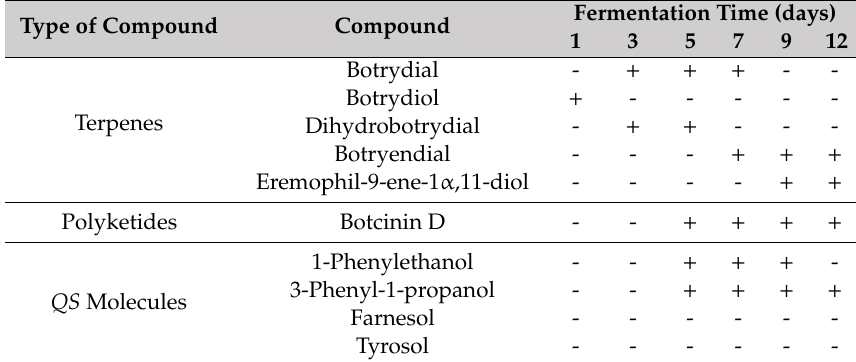
Table 2. Compounds detected in B. cinerea extracts according to the time of fermentation. Fermentation Time (days) Type of Compound Compound 1 Botrydial - + + + - - Botrydiol + - - - - - Terpenes Dihydrobotrydial - - Botryendial - - Eremophil-9-ene-1 α ,11-diol - - - Polyketides Botcinin D - - 1-Phenylethanol - QS Molecules - - -